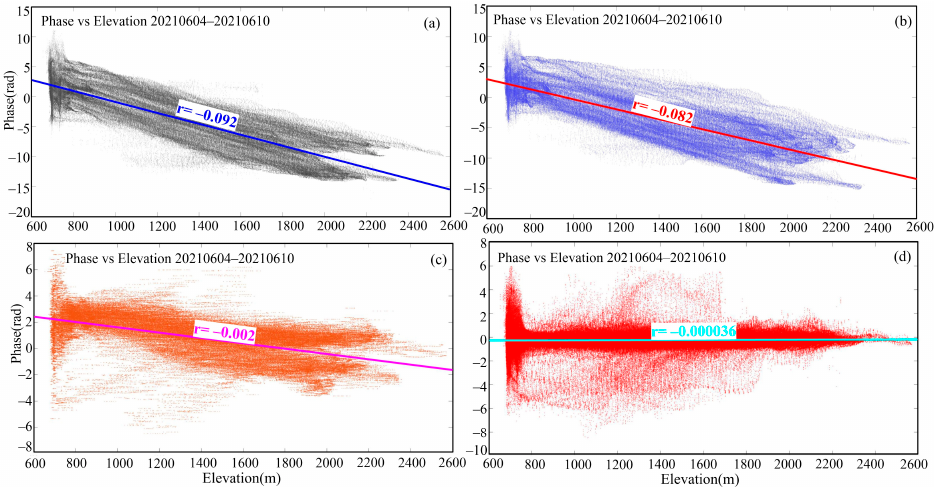
Figure 6. Interferometric map 20210604–20210610 phase and elevation linear fit analysis:( a ) the original phase with elevation; ( b ) phase corrected by linear model with elevation; ( c ) phase corrected by GACOS with elevation; ( d ) phase corrected by MLP neural network model with elevation.